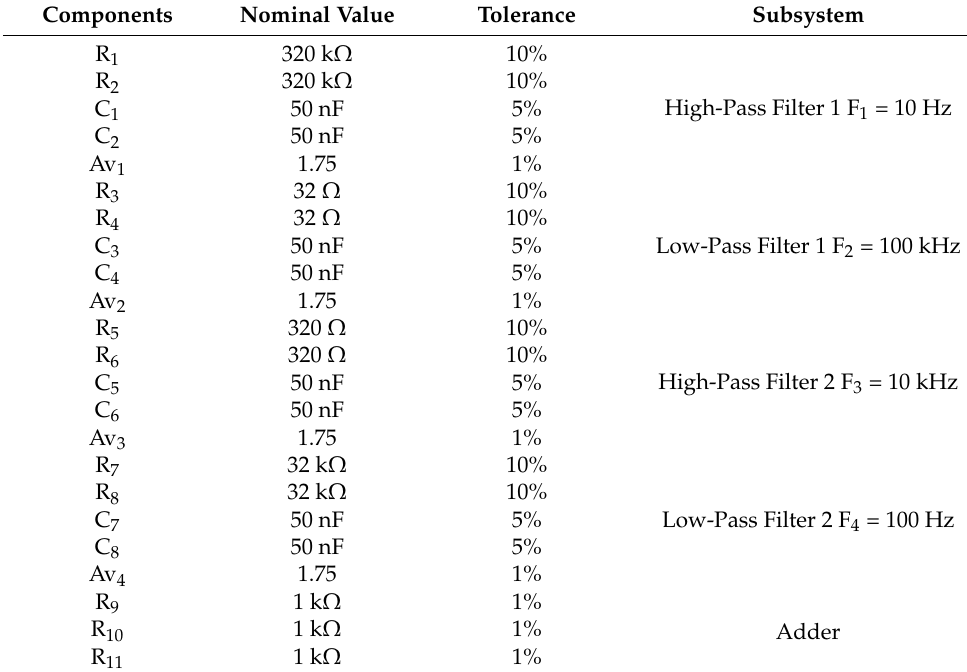
Figure 5. Target analog circuit. Table 1. Details for the components of the circuit.